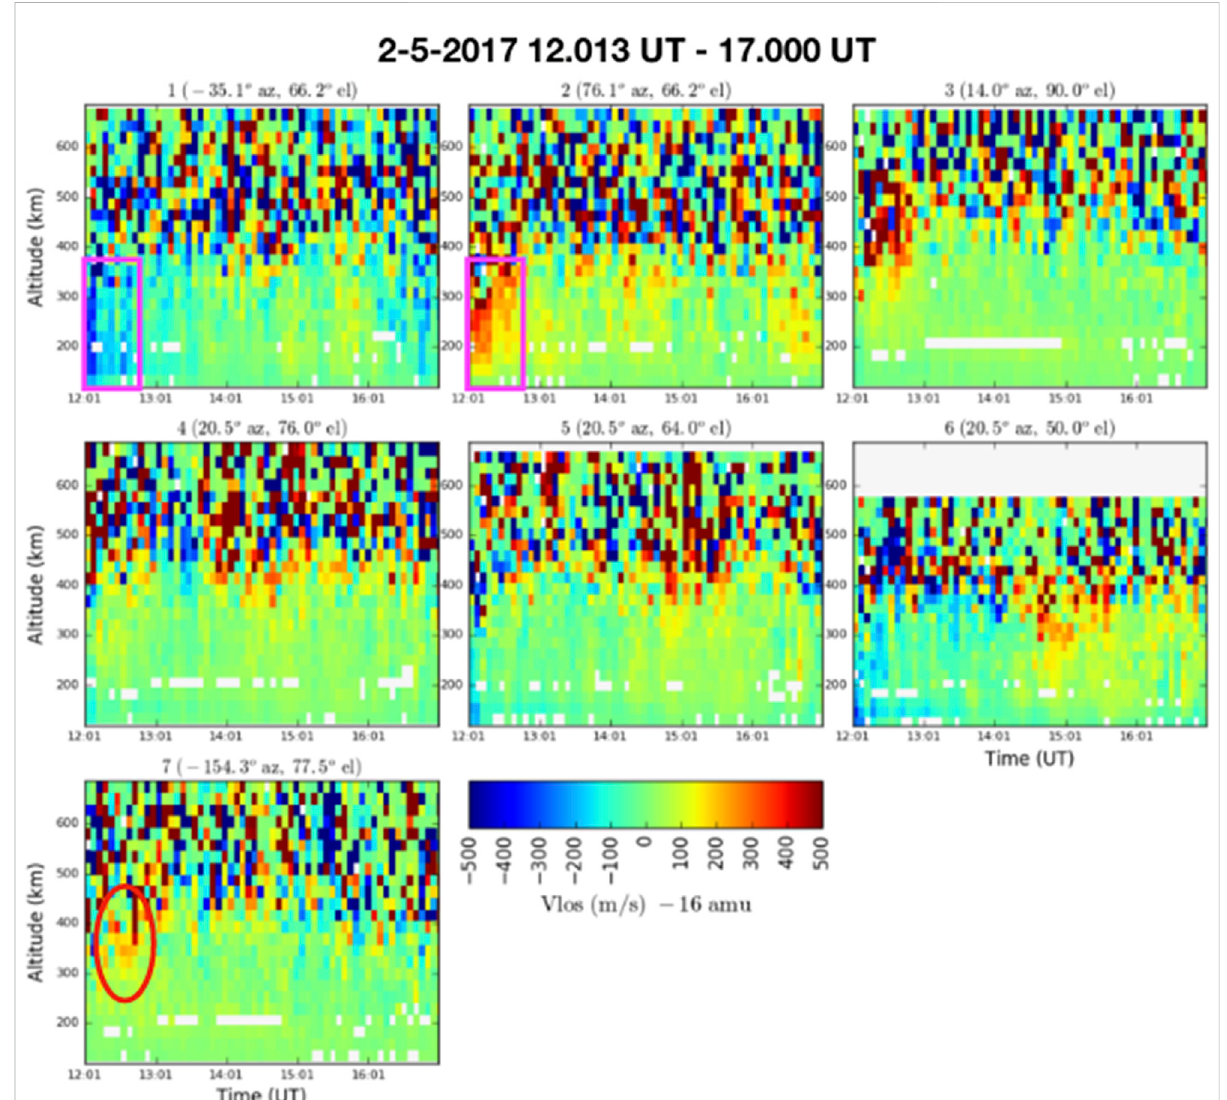
FIGURE 2 Line-of-sight velocity data for each of the seven PFISR beams. Positive values denote ion motion away from the beam, while negative values denote ion motion toward the beam. A single column within the plot represents a 5 min integration period. The vertical axis displays the height resolutionoftheradarpulse.Theredcircleindicatestheionup fl owsignatureobservedinBeam7,whilethemagentaboxeshighlighttheconvection signature present in Beams 1 and